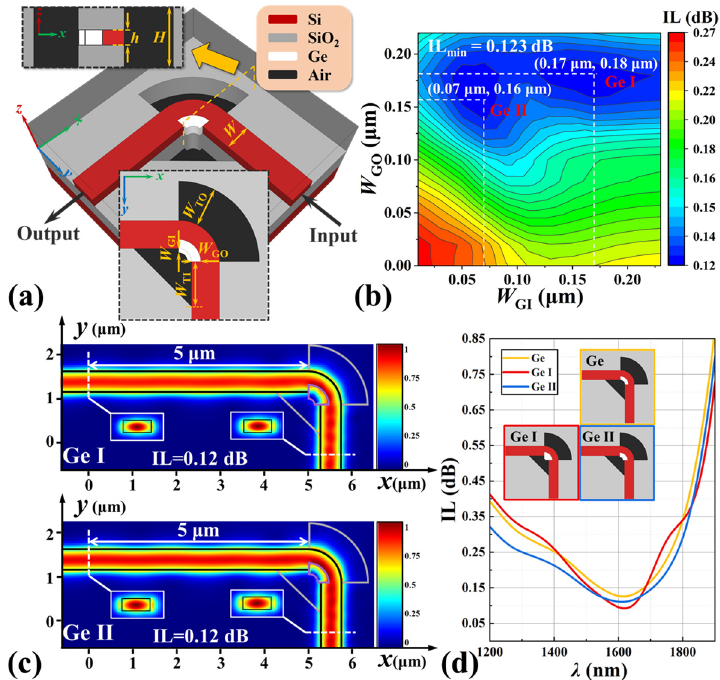
Figure 4. ( a ) Schematic of the silicon waveguide bend with the embedded Ge arc extended toward the inside and outside of the waveguide bend. The extended arc widths are set as W GI and W GO . ( b ) Device IL dependent on these extended arc widths ( W GI , W GO ). Two regions with lowest ILs are marked as Ge I and Ge II. ( c ) Electric field evolution (| E |) through the designed bend with Ge I and Ge II structural types, where | E | stands for the norm of electric field. ( d ) Wavelength spectra of IL for the proposed waveguide bend with embedded Ge arc types.